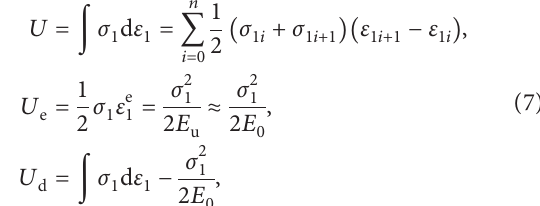
Figure 5: The calculation of the energy U